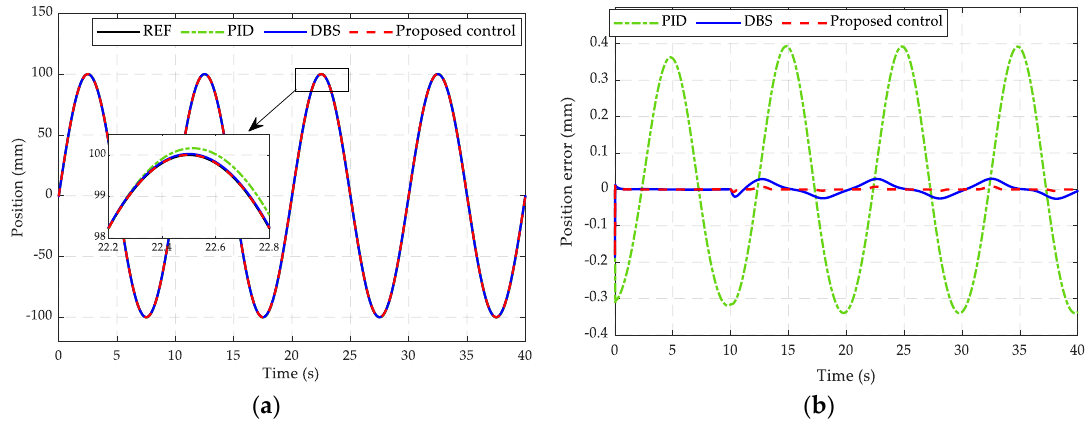
Figure 4. Comparison of sinusoidal trajectory and no loading condition. ( a ) Position-tracking performance. ( b ) Error effort.